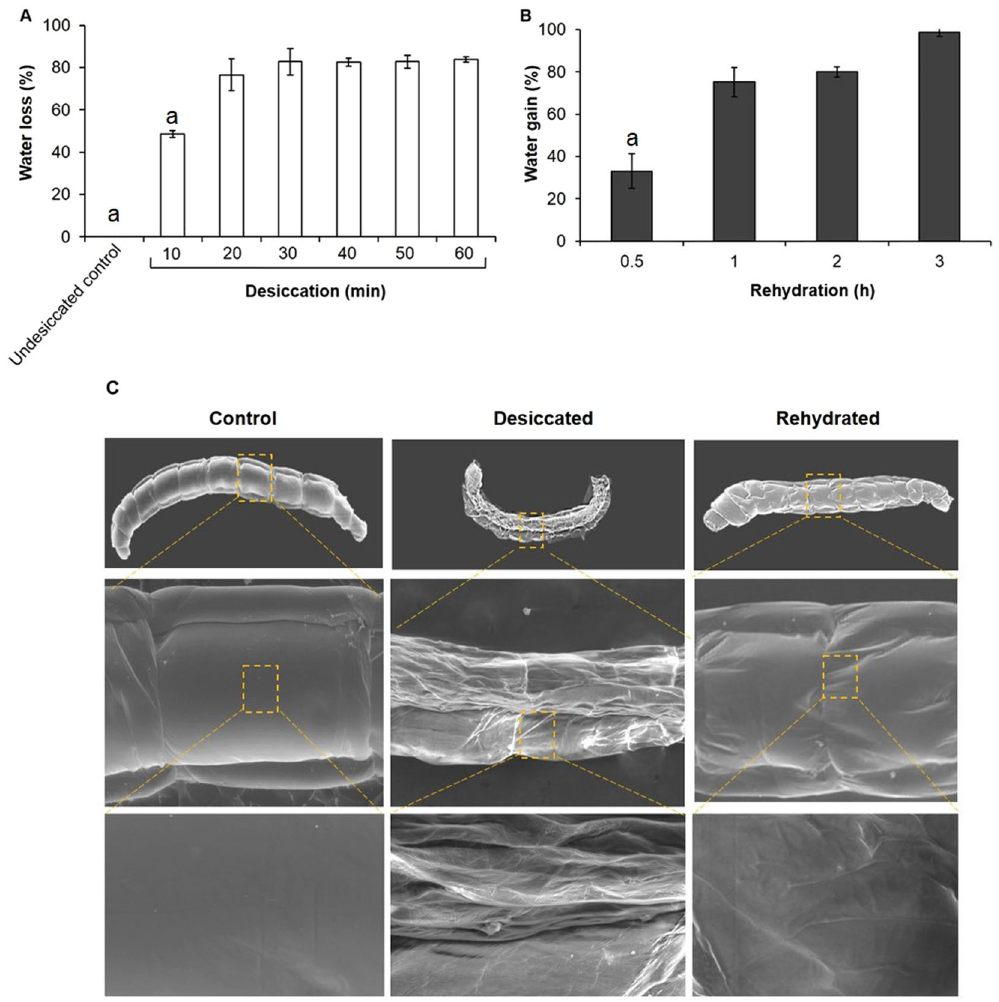
Figure 1. Overview of desiccation stress response in C. ramosus larvae. ( A ) Water loss during progressive desiccation. Data represented are mean ± SD of three replicates (a = p < 0.05 vs 40 min desiccation). ( B ) Water intake upon rehydration. Data represented are mean ± SD of three replicates (a = p < 0.05 vs 3 h rehydration). ( C ) Representative E-SEM photomicrographs of control, desiccated and rehydrated larvae showing surface topology of whole larva (top panel; x30), segment of the larval body (middle panel; x250) and view of outer integument (last panel;